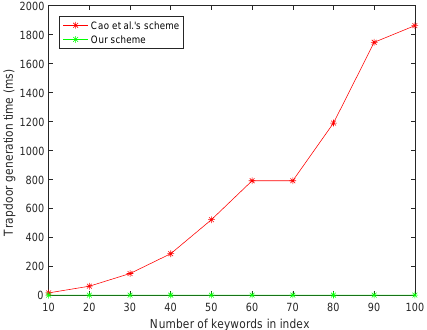
Figure 8. Time cost on search trapdoor